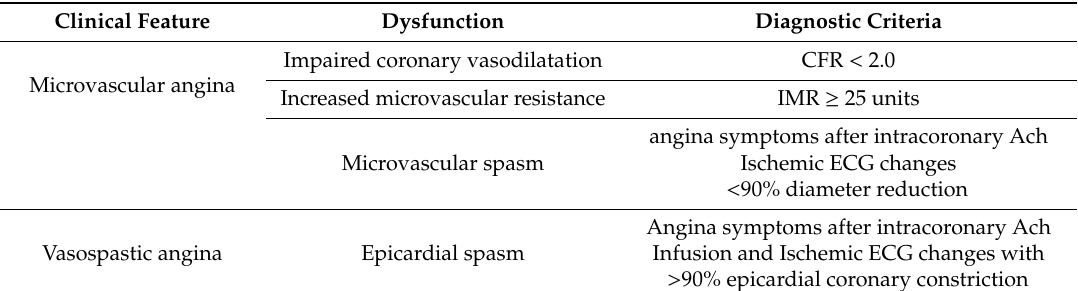
Table 3. Invasive diagnostic criteria for